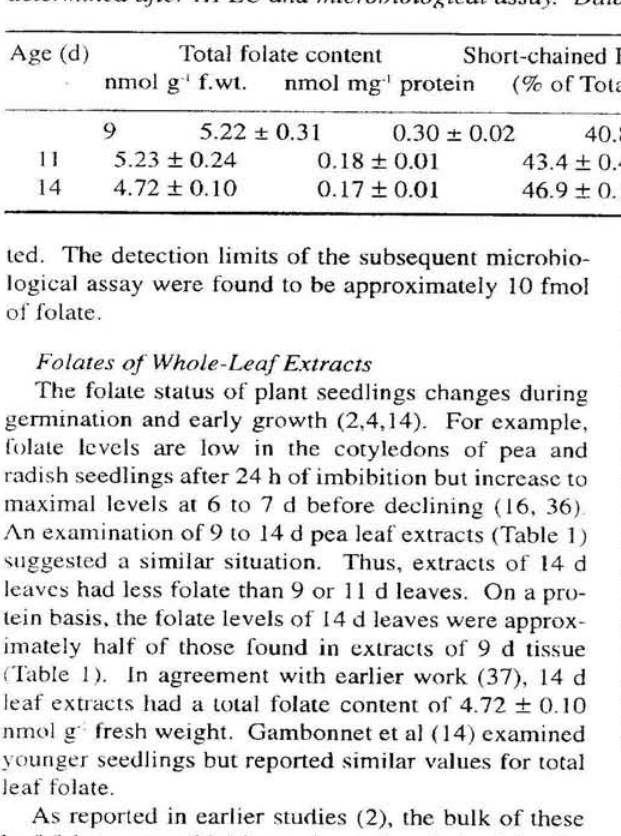
Table 1. The folate content of pea leaves. Pea leaves (excised from 9 to 14 day seedlings) were extracted and assayed for total folate using L. rhamnosus (see Materials and Methods). assay of leaf extracts prior to GGH treatment. folates